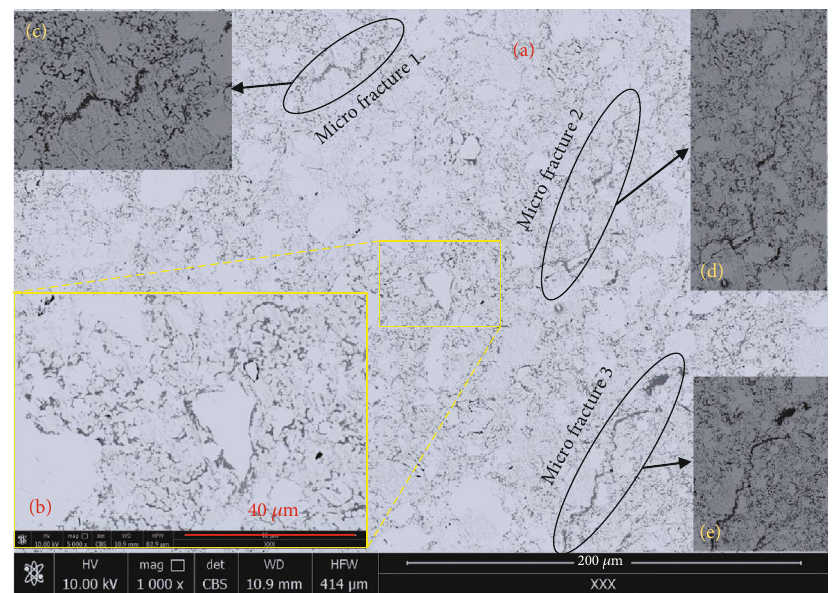
Figure 1: The microscopic pore of shale